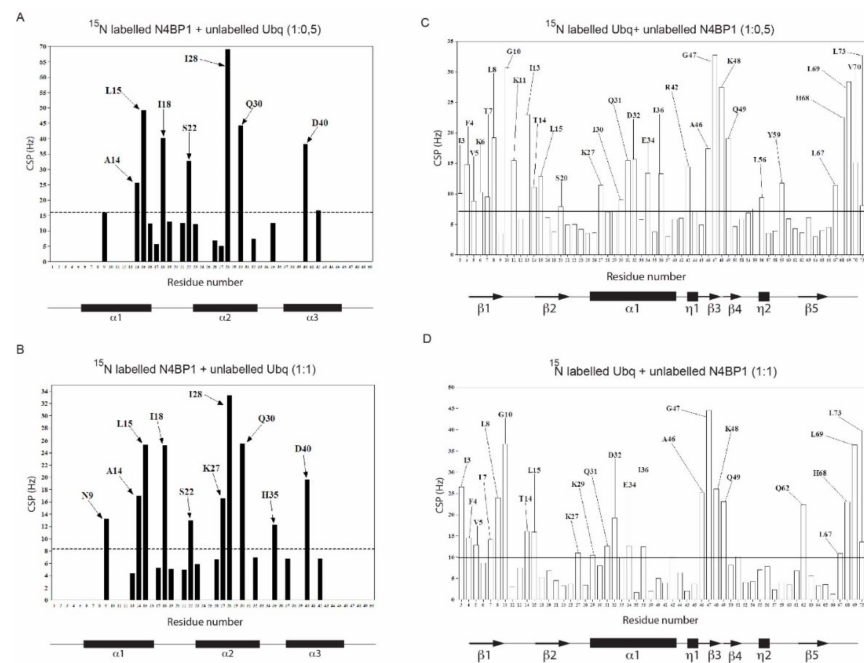
Figure 5. ( A , B ) Chemical shift perturbation spectra of 15 N labeled N4BP1 in the presence of ubiquitin respectively at 1:0.5 and 1:1 molar ratios. ( C , D ) Chemical shift perturbation spectra of 15 N labeled ubiquitin in the presence of N4BP1 at 1:0.5 and 1:1 molar ratios,